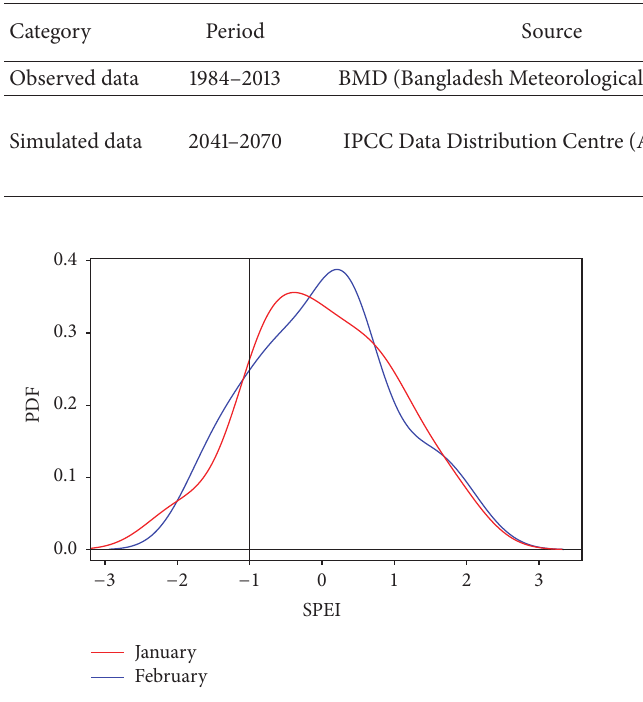
Figure 2: The PDFs of SPEI values in January and February during the observed period of 1984–2013 in Rangpur, northwestern